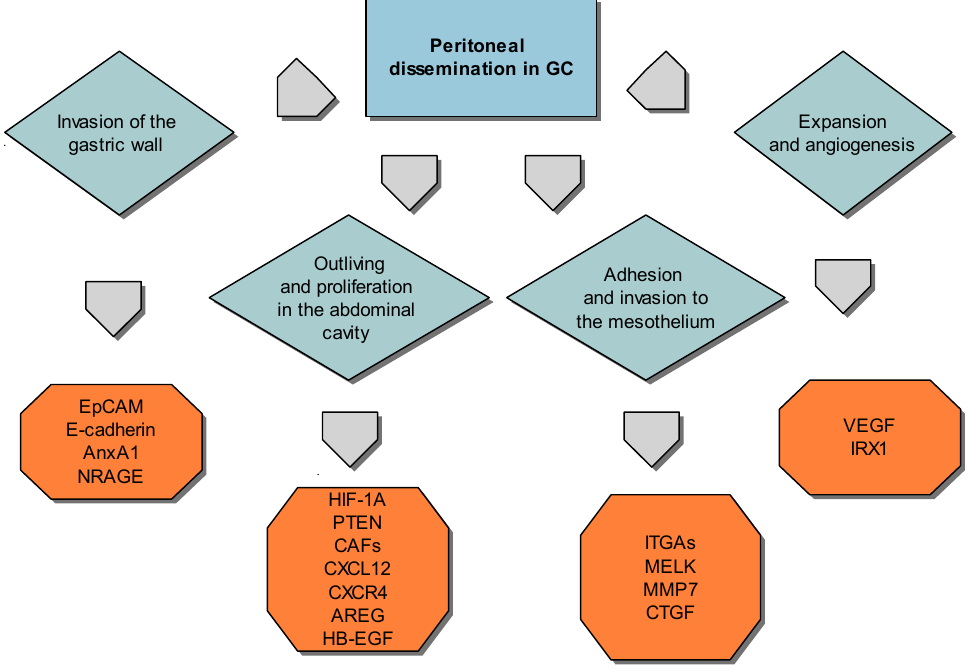
Figure 1. Peritoneal dissemination steps and molecular markers.